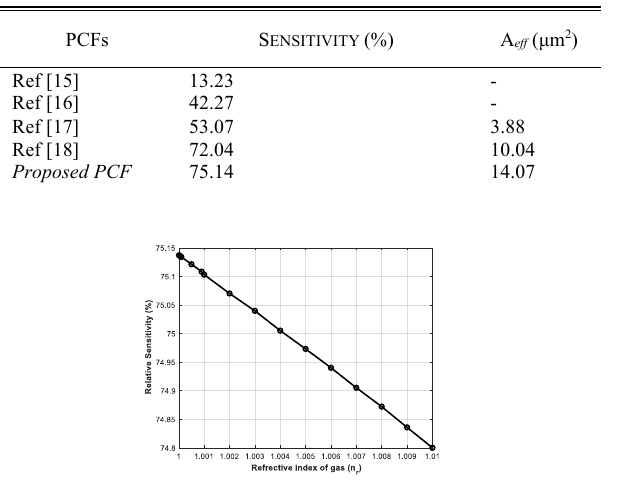
TABLE II. Comparison between the reported relative sensitivity with PCFs in the literature at λ =1.33 μ m.